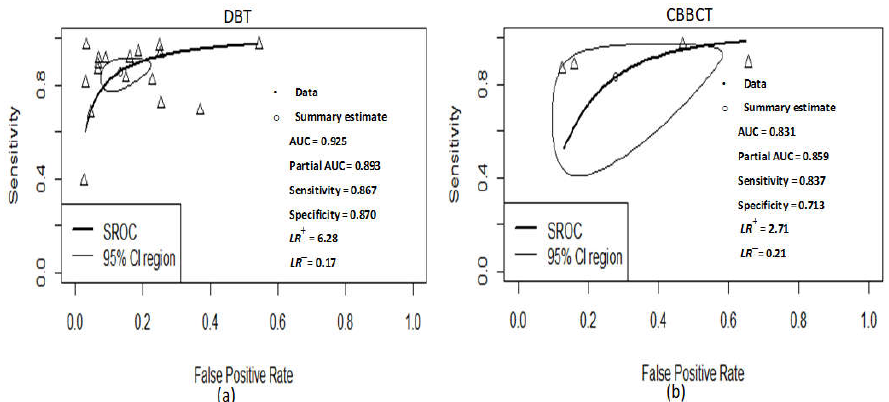
Figure 7. The plot of diagnostic performance using bivariate Summary Receiver Operating Char- acteristics (SROC) curve. ( a ) SROC of DBT; ( b ) SROC of CBBCT. The prediction region is shown in a dashed dark line, the confidence region shown in a small black ellipse, summary point in black diamond plus ad scaled dataset points for each study in a small triangle. CI: Confidence interval; AUC: area under the curve.